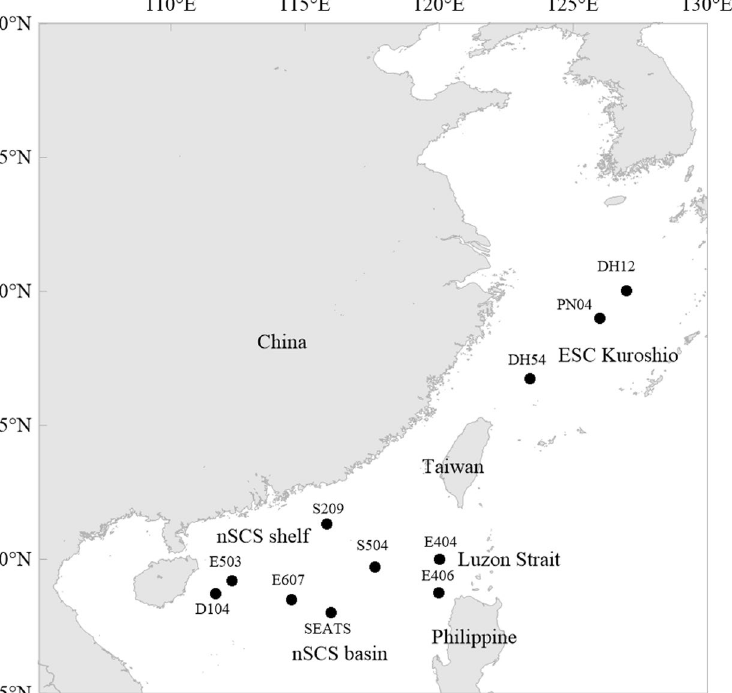
Figure 8. Sampling stations of N 2 fixation rate. Note for software: Golden Software Surfer 11 (http://www.